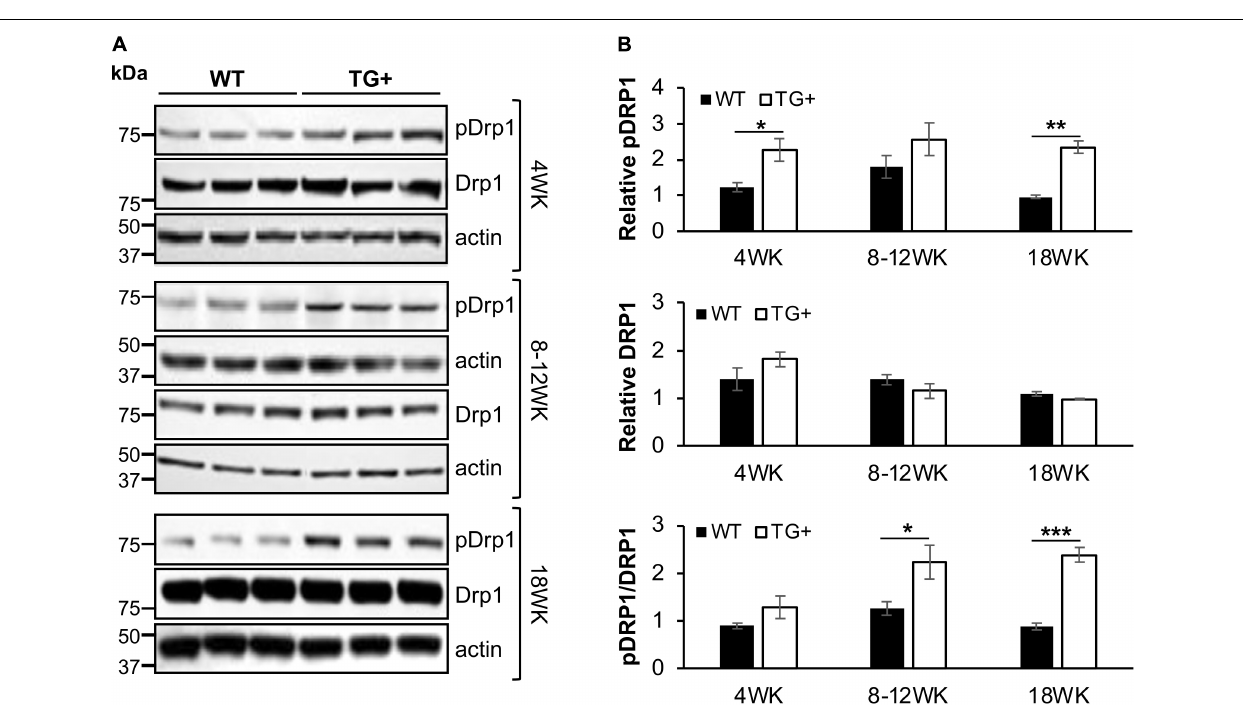
FIGURE 3 | Mitochondrial fission protein Drp1 is progressively overactivated in the cerebellum of FRDAkd mice. (A) Western blot analysis of pDRP1 (S616), Drp1, and internal loading control (actin) levels in cerebellum of WT and TG + mice at 4 weeks, 8–12 weeks, and 18 weeks of dox treatment. (B) Quantification (normalized to actin) of pDRP1 (top panel), Drp1 (middle panel), and pDrp1/Drp1 ratio (bottom panel) normalized to actin (Stats: WT, n = 3, TG + , n = 3, mean ± SEM, two-tailed, unpaired Student’s t -test, * P < 0.05, ** P < 0.01, *** P <